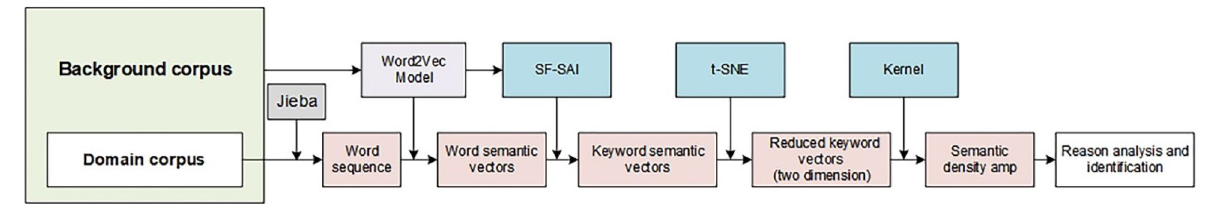
Figure 1. Flowchart of the semantic analysis of the causes of inferiority feelings (Drawing with WPS Office 2019 30 ).